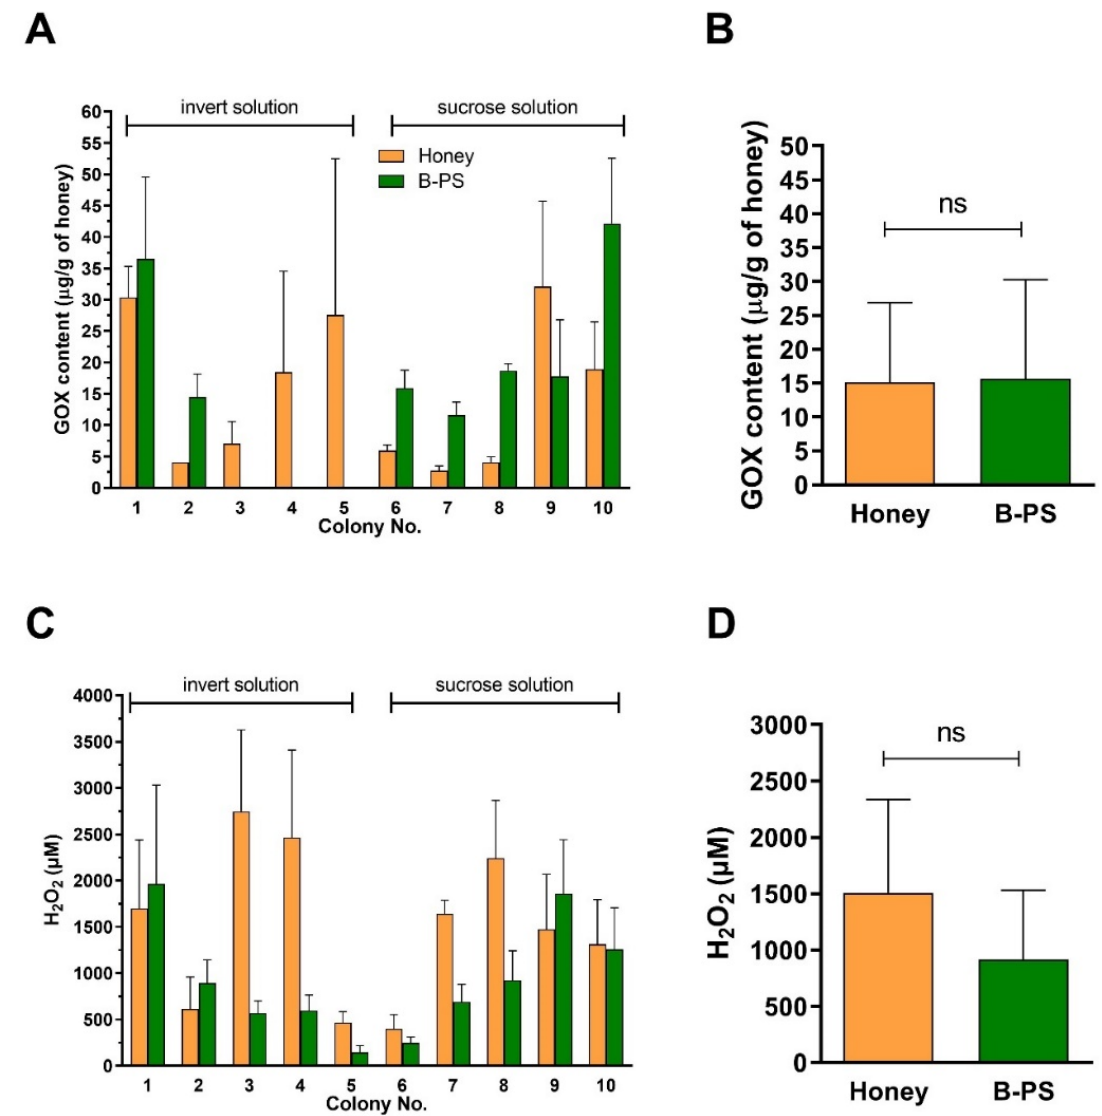
Figure 3. GOX contents and H 2 O 2 levels in raw honey samples and bee-processed syrups (B-PS) from bee colonies ( n = 10) ( A , C ). Honey and bee-processed syrup were subsequently collected from the same colonies. ( B , D ) Average GOX content and levels of H 2 O 2 for honey samples and bee-processed syrups. Data are expressed as the mean values with SD.